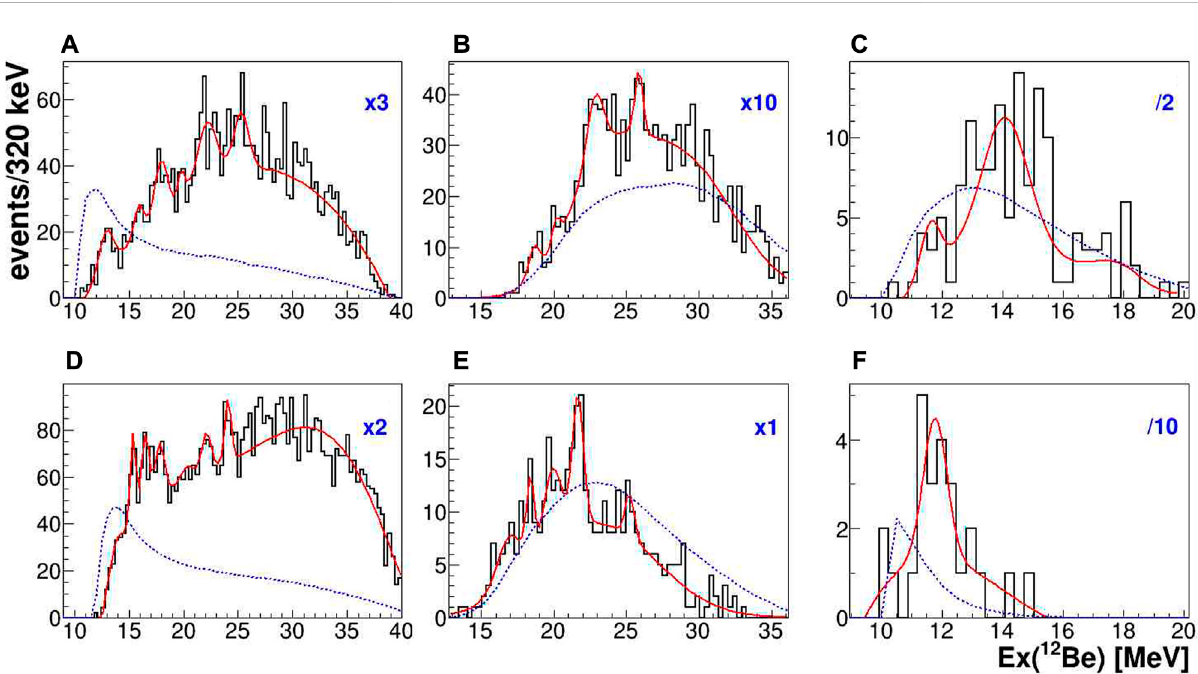
FIGURE 5 Examples of the 12 Be excitation energy spectra for the 6 He + 6 He decay. Spectra are reconstructed for the 4 He + 6 He coincidences for dT = 3andundetected 6 Heinthegroundstate (A) ; 6 He+ 6 HecoincidencesfordT=3 (B) anddT=1 (C) ; 4 He+ 6 HecoincidencesfordT=3andundetected 6 He inthe fi rst excitedstate (D) ; 6 He + 6 He coincidencesfor dT =2 (E) and dT = 0 (F) .Solid red curves are results of thebest fi t using Gaussian curves for the peaks on the estimated background. Dotted blue curves represent the detection ef fi ciency calculated by Monte Carlo simulations multiplied by the labeled